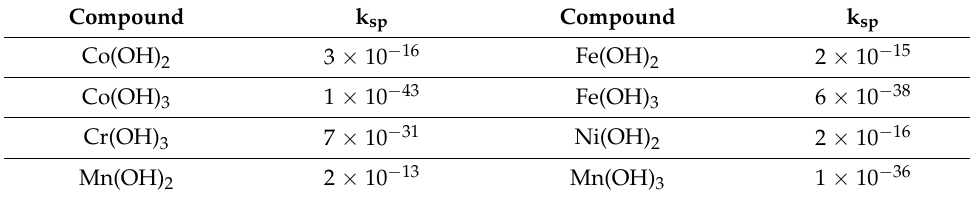
Table 4. Constants of solubility product k sp for hydroxides of Co, Cr, Fe, Ni, and Mn [41]. Compound k sp Compound k sp